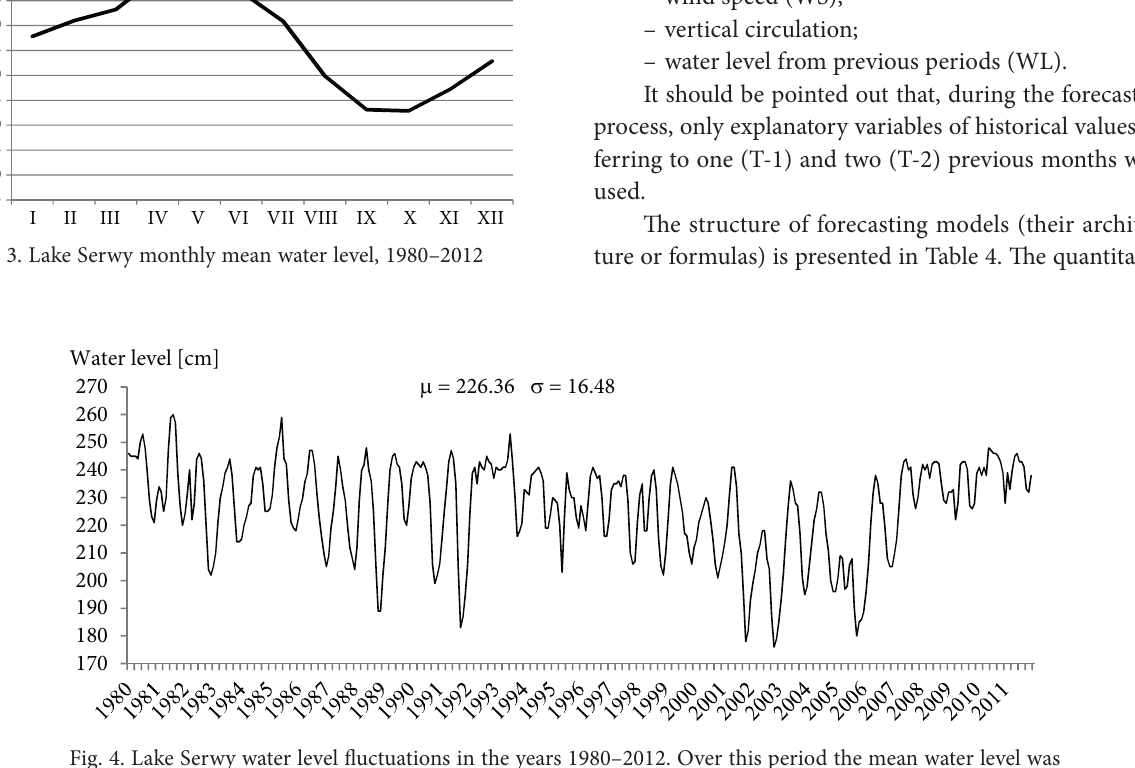
Fig. 4. Lake Serwy water level fluctuations in the years 1980–2012. Over this period the mean water level was equal to µ = 226.36 cm with a standard deviation of σ = 16.48 cm